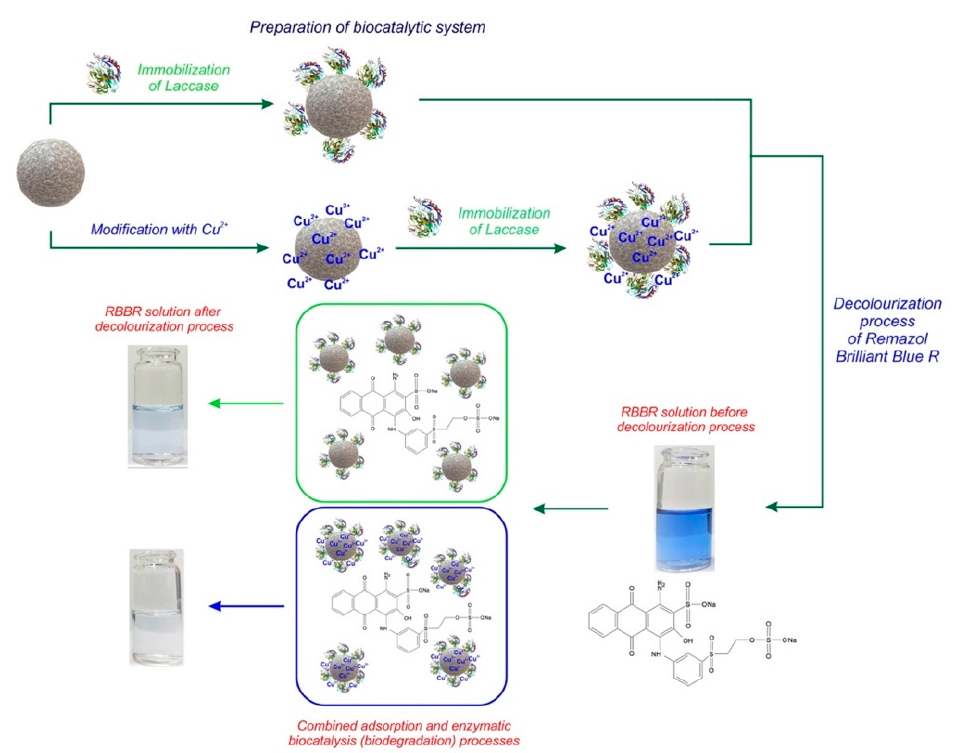
Figure 2. Schematic diagram of preparation of biocatalytic systems and decolorization process of Remazol Brilliant Blue R (RBBR) dye.